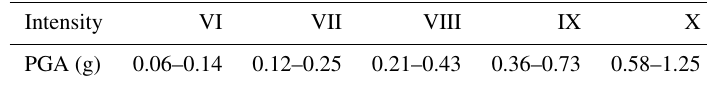
Table 6. The PGA ranges derived from more intensity–PGA relations (Sect. 5.5).